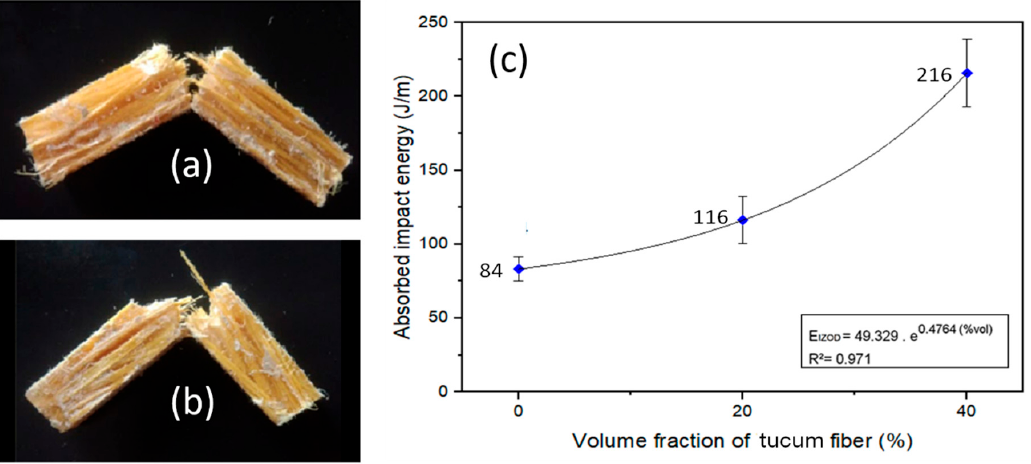
Figure 10. Composites fractured by impact Izod: ( a ) 20 vol%, and ( b ) 40 vol% of tucum fiber/epoxy, and ( c ) variation of the absorbed impact energy with volume fraction of tucum fiber.